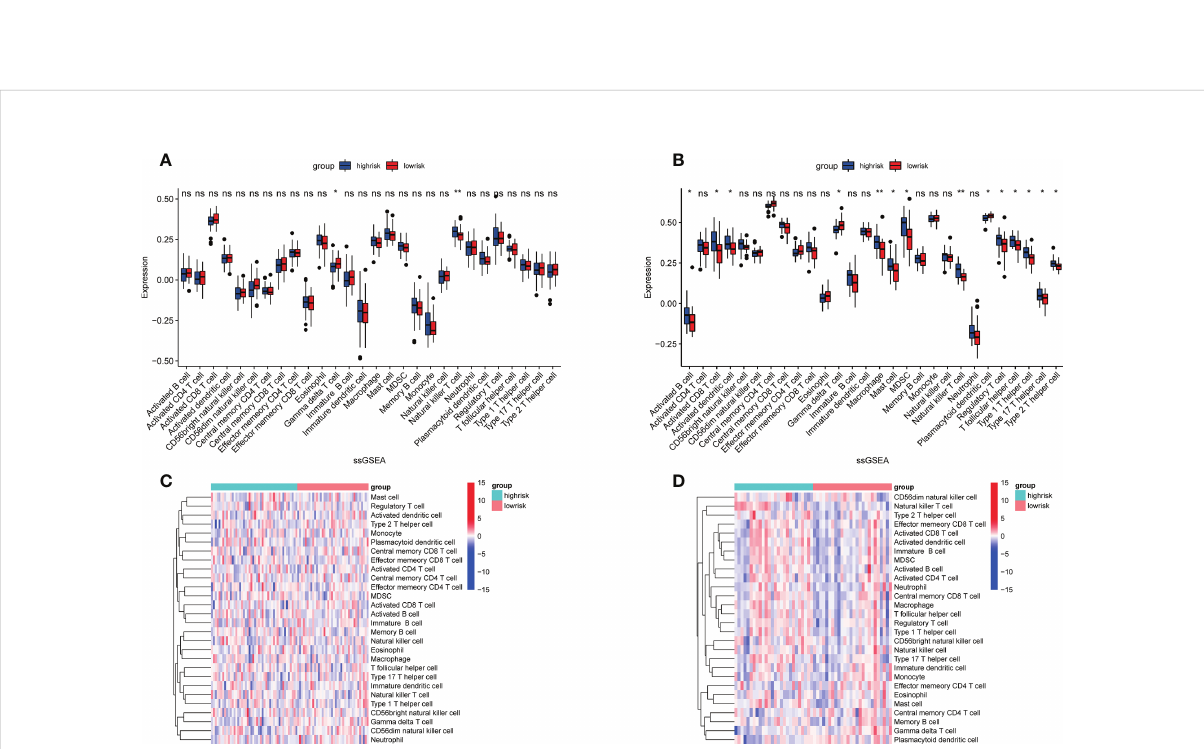
FIGURE 8 Assessment of immune cell in fi ltration in OS tissue from high- and low-risk patients using the ssGSEA method. (A, B) Differences in immune cell in fi ltration between high- and low-risk OS patients. *p<0.05; **p<0.01; NS, no signi fi cance. (C, D) Heatmap depicting the enriching level of 28 immune related cells evaluated by ssGSEA